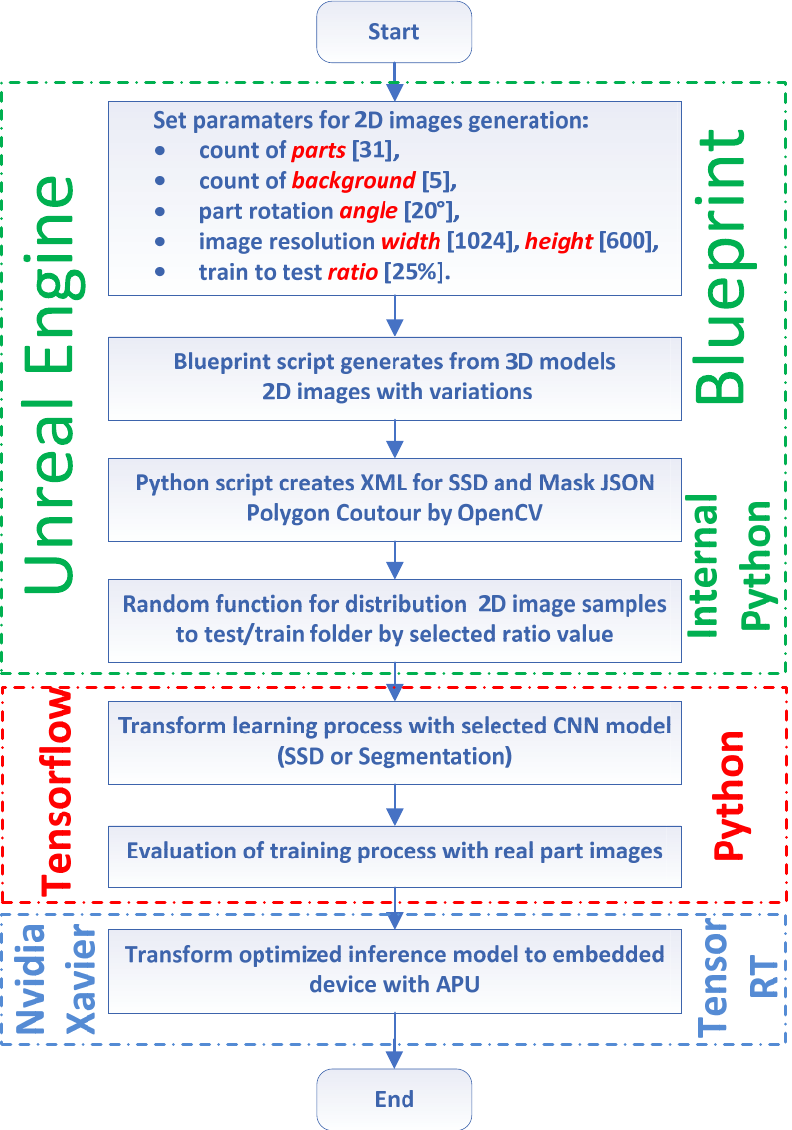
Figure 1. The simplified algorithm for samples generation from 3D virtual models of assembly parts.